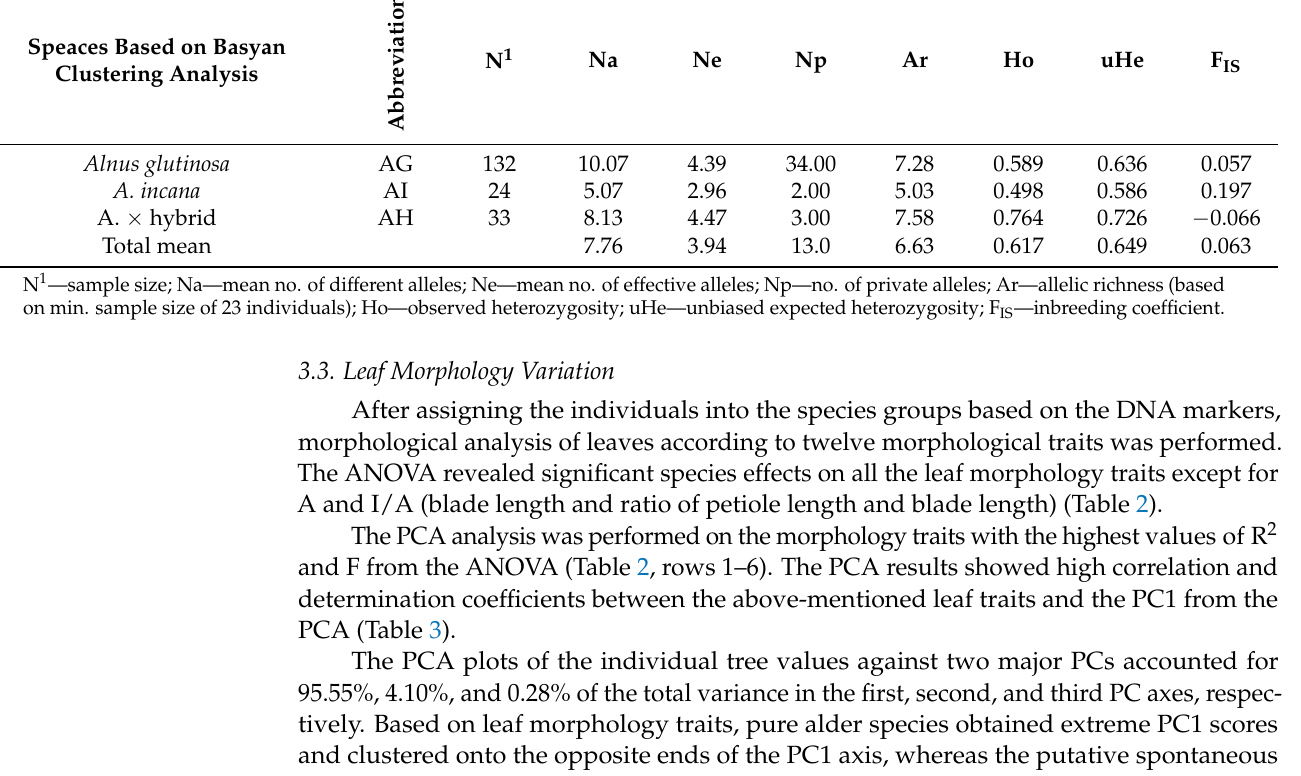
Speaces Based on